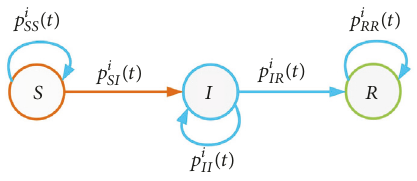
Figure 2: The state transition diagram of user 𝑖 at time 𝑡